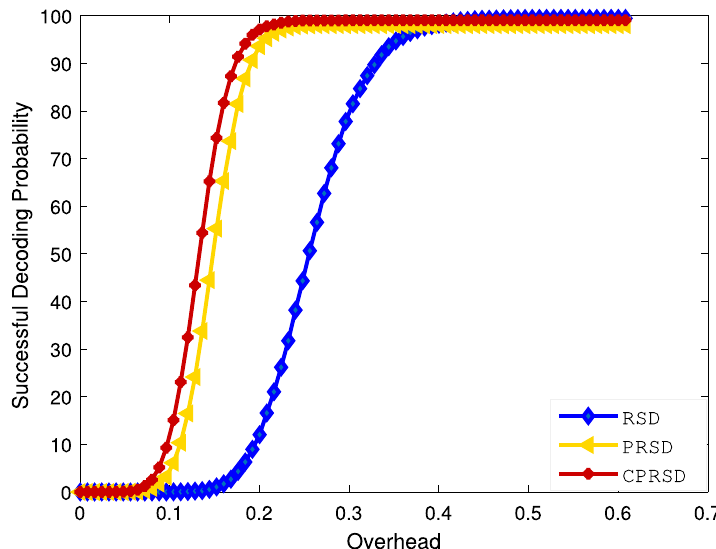
Fig. 9 Successful decoding probability for k = 250 in non-removal